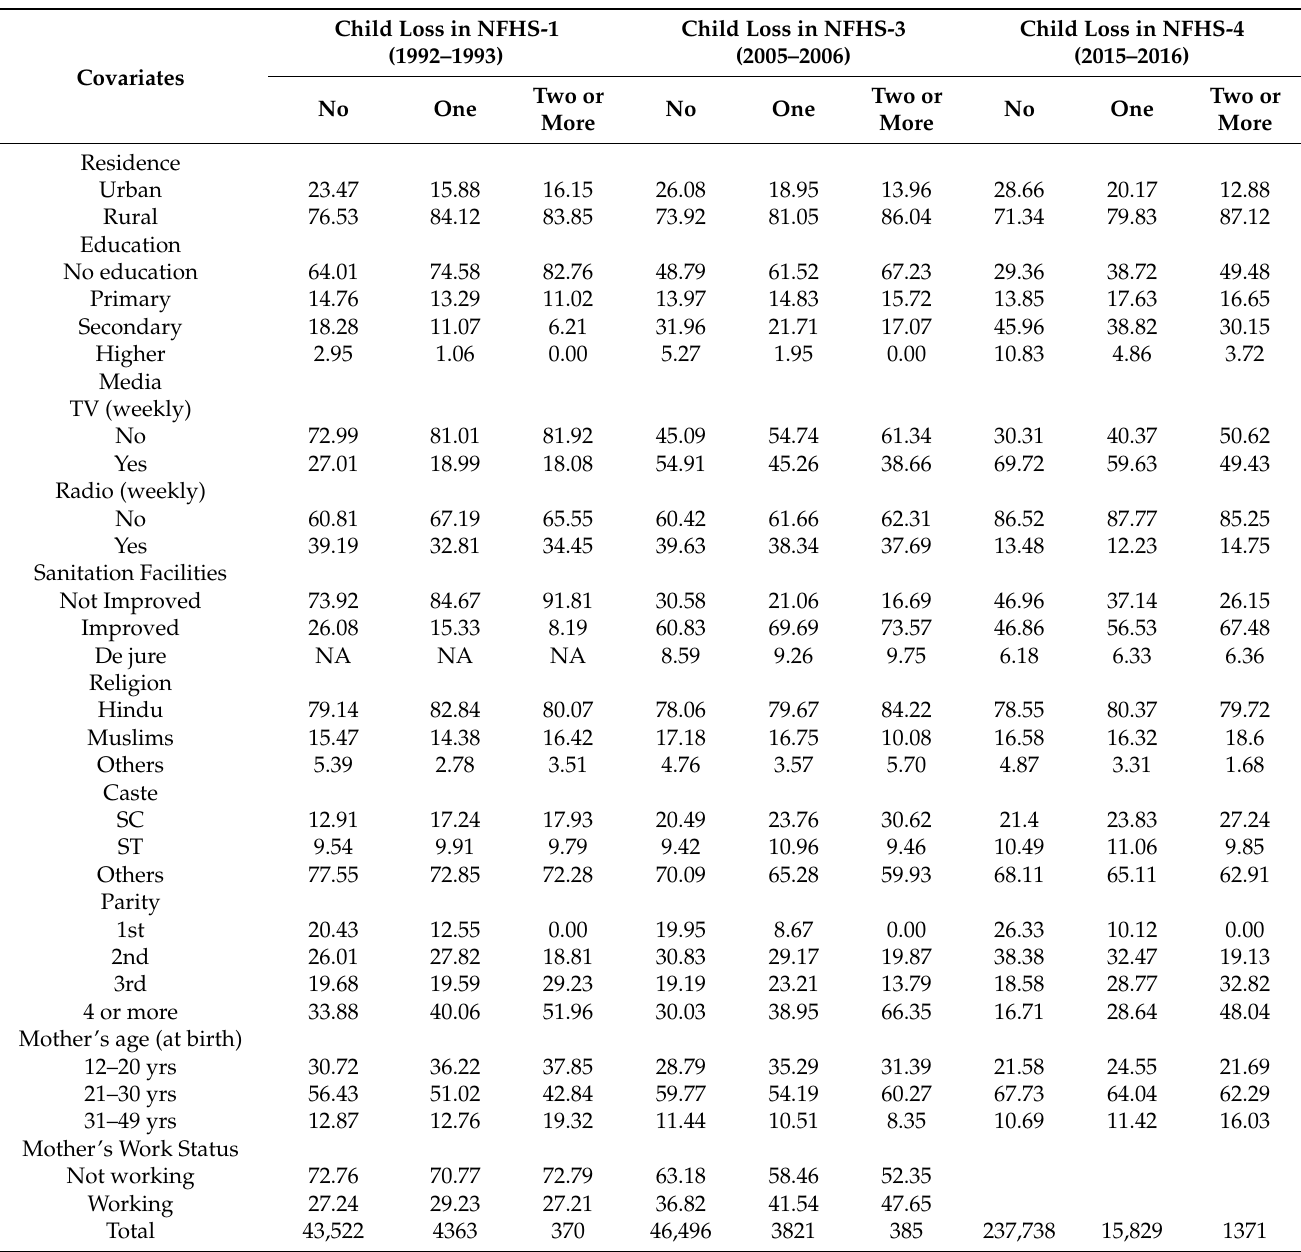
Table 8. Socio-demographic characteristics of women with no child loss, women with exactly one child loss, and women with loss of two or more children, India,